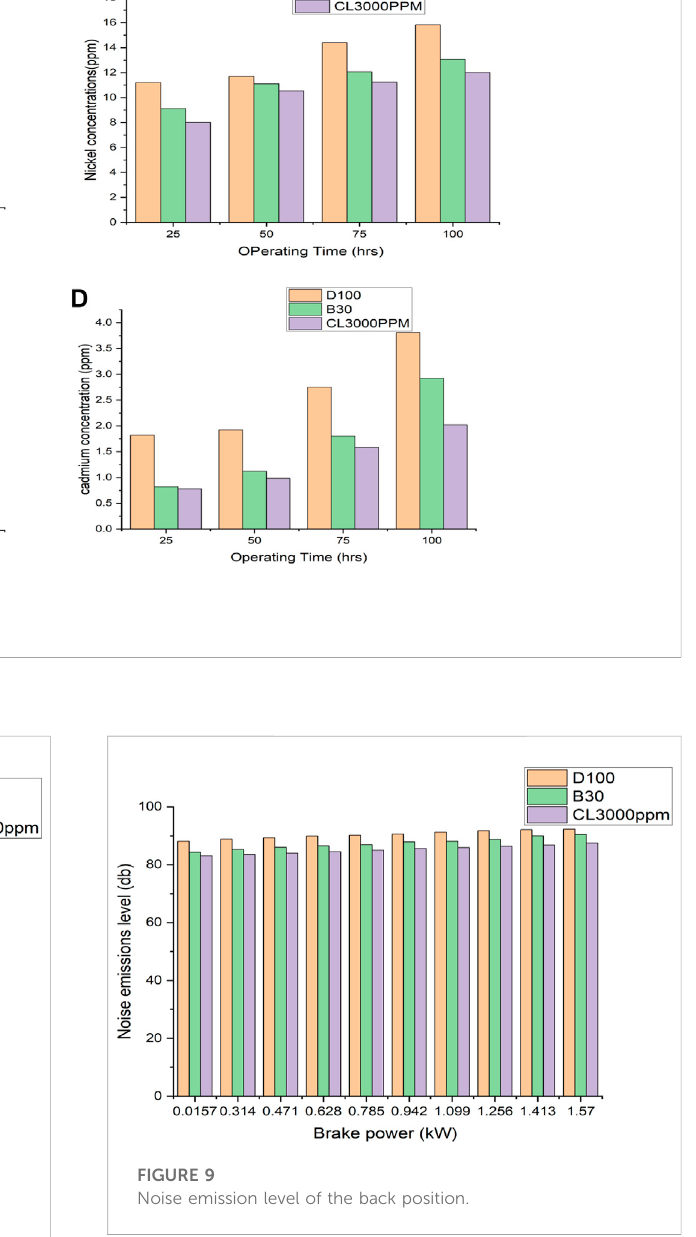
FIGURE 9 Noise emission level of the back